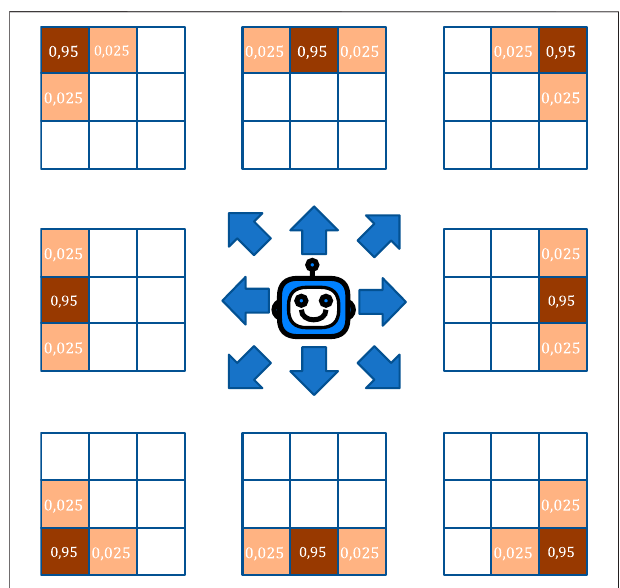
FIGURE 8 | Action probability tensor with an error probability of 5% on neighboring actions.